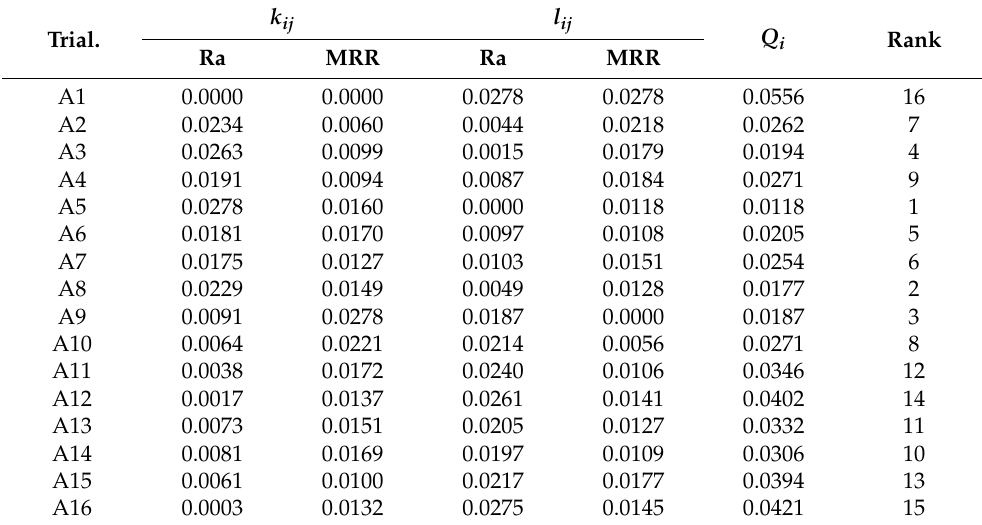
Table 8. Calculated results and ranking of alternatives by the MAIRCA method.